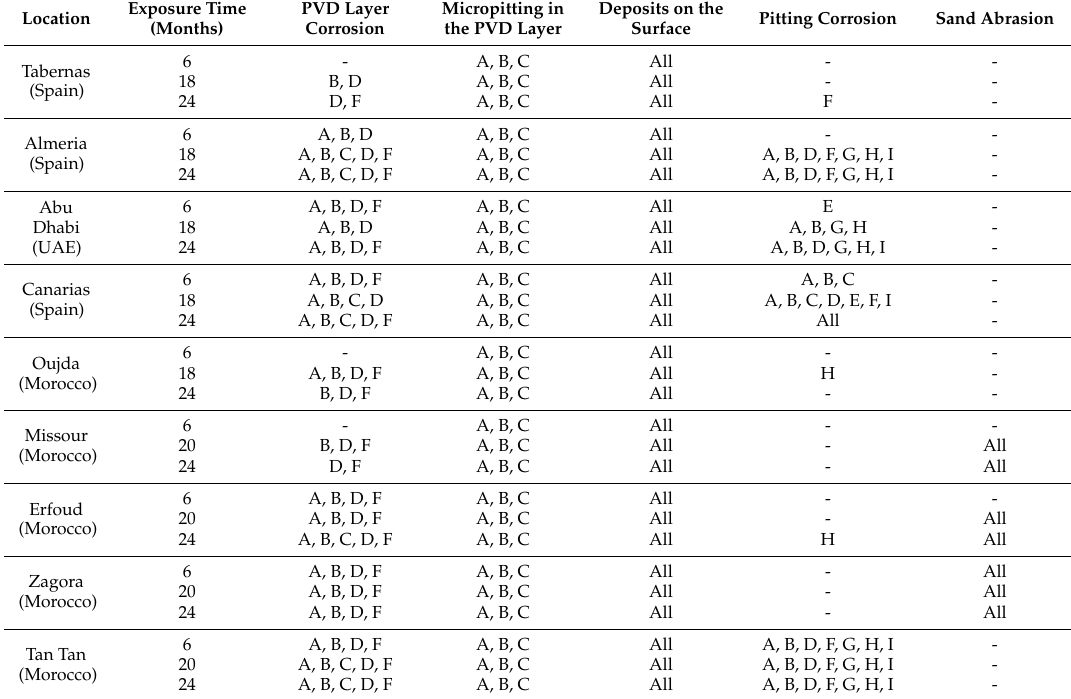
every exposure site.